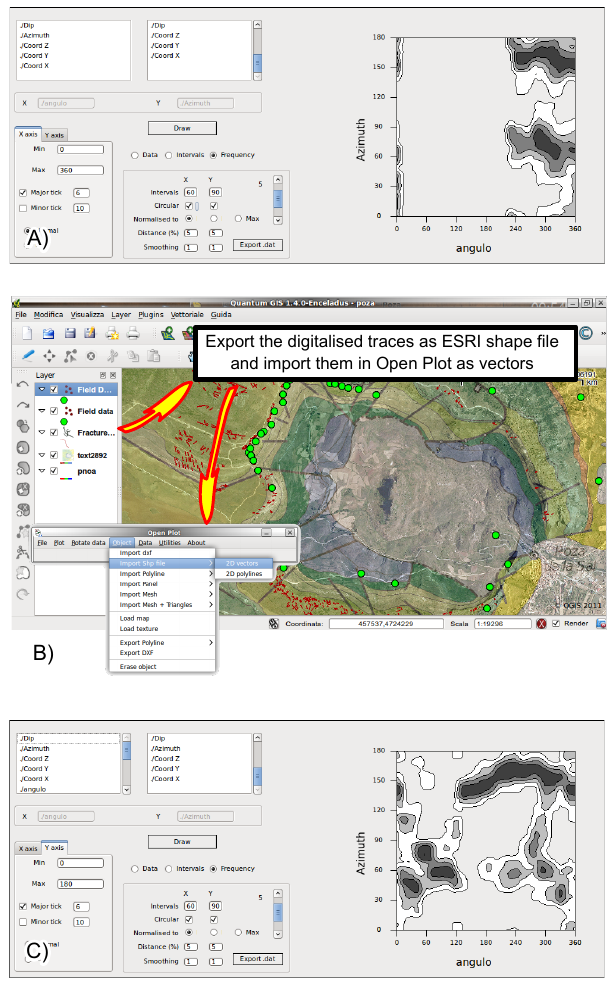
Fig. 11. (a) Scatterplot of polar coordinate vs. azimuth (0–180 ◦ ) of joints. (b) Procedure for importing an ESRI shape file into Open Plot. (c) Scatterplot of polar coordinate vs azimuth of digitalised fracture